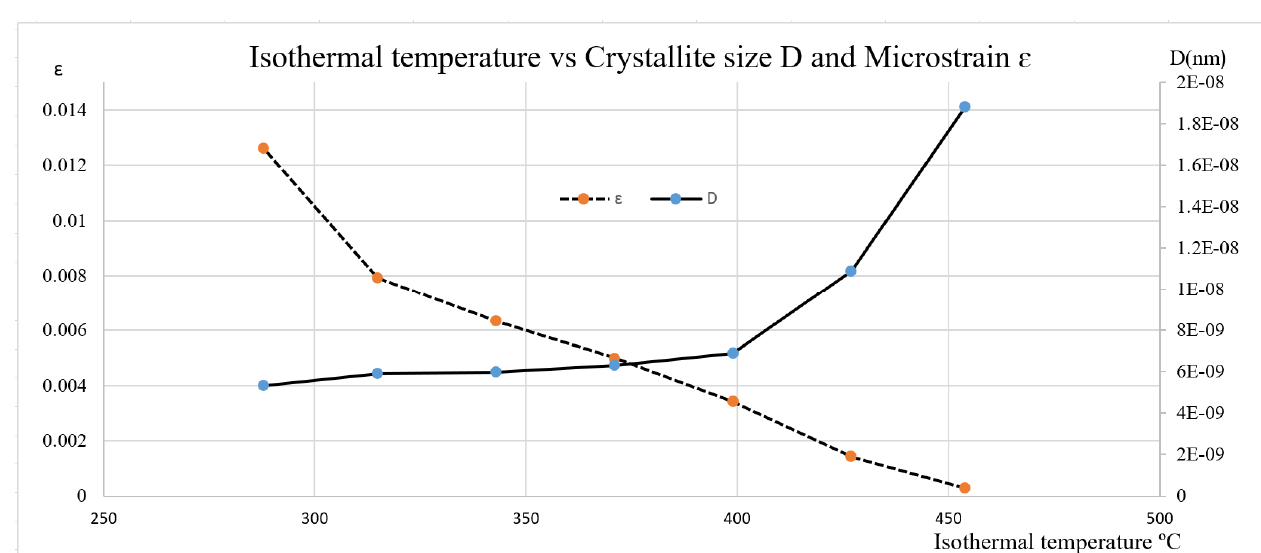
Figure 6. Isothermal temperature effect on crystallite size and microstrain.